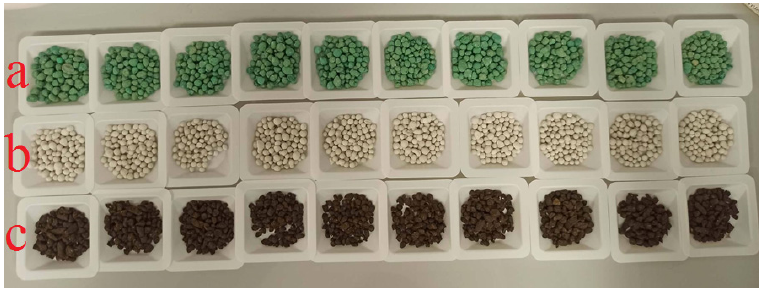
Figure 5. A hundred granule measuring cups: ( a ) Agro NPK; ( b ) Substral; and ( c ) Agro Organic.